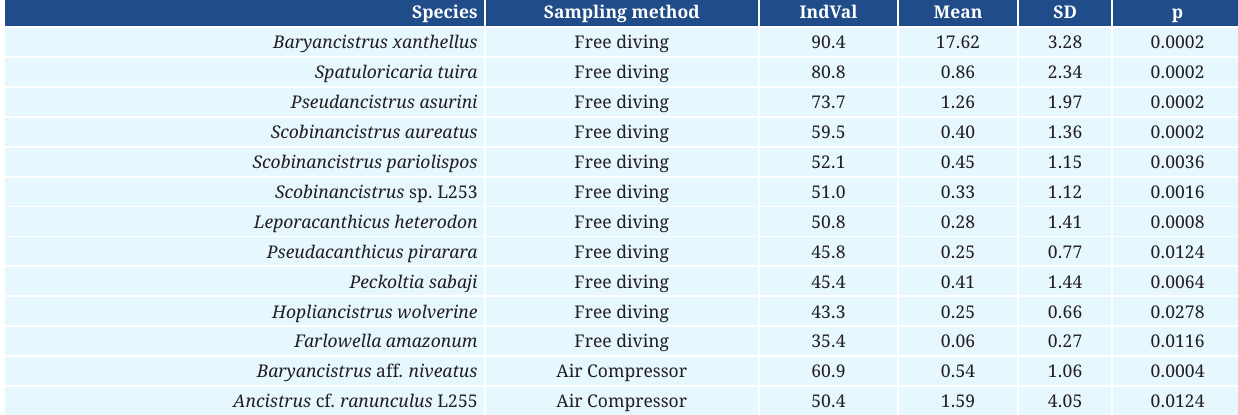
TABLE 2 | Indicator value (IndVal) of the species for different sampling methods.